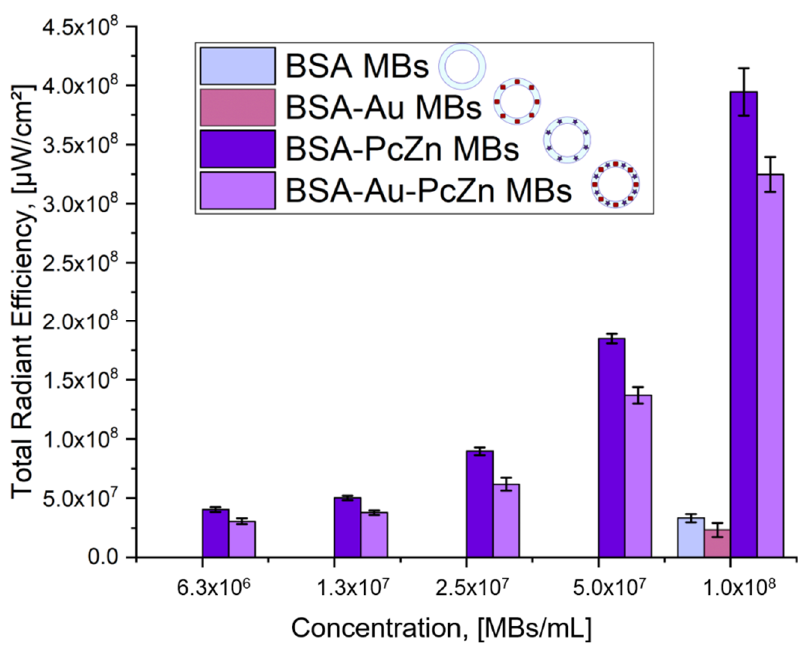
Figure 5. Total radiation efficiency calculated based on fluorescence imaging of samples: BSA MBs, BSA-Au MBs, BSA-ZnPc MBs, and BSA-Au-ZnPc MBs at excitation/emission pair of 675/720 nm at different bubble-micromotors concentrations.